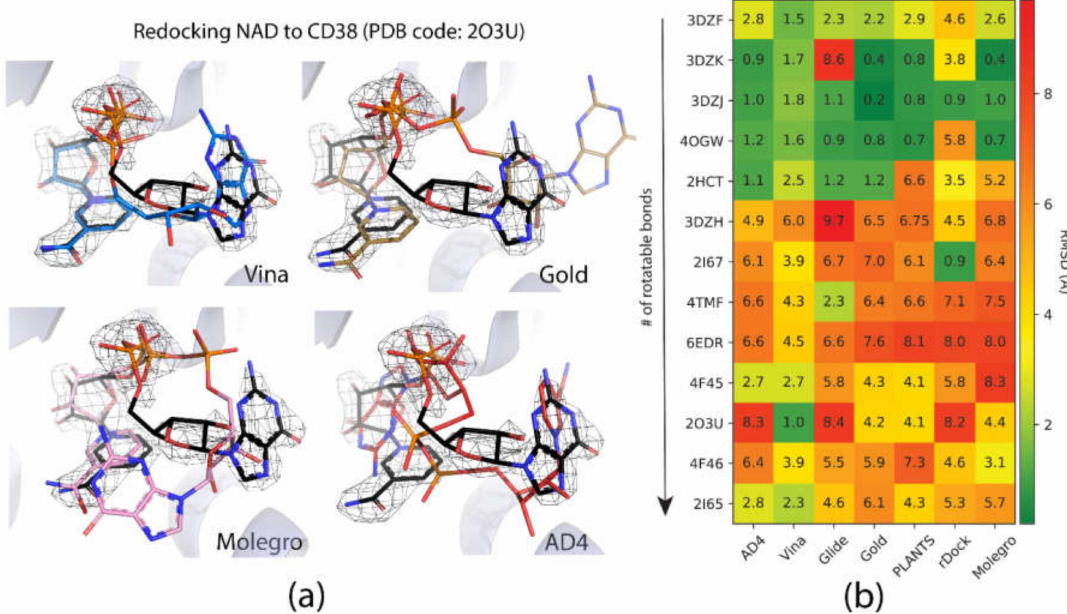
Figure 3. Comparisons of the redocking performance of all programs across the CD38 test set. ( a ) An example of the results produced when redocking NAD to a crystal structure of CD38 (PDB code: 2O3U). The native pose and isomesh of the electron density at 2 σ in the 2f c –f o map are shown in black. Poses were selected to be representative of the average RMSD across ten trials. In the case of all programs, the orientation of the nicotinamide fragment (essential to the catalytic mechanism of CD38) was successful, apart from AutoDock 4, which did not reproduce this feature. ( b ) A heatmap indicating the average RMSD for each program across all CD38 structures in the test set is shown. Models are sorted on the y-axis by the number of rotatable